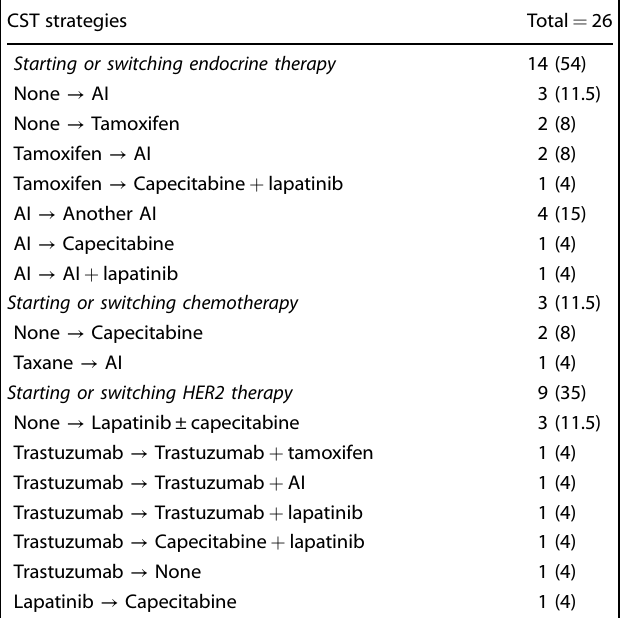
Table 3. Change of systemic therapy